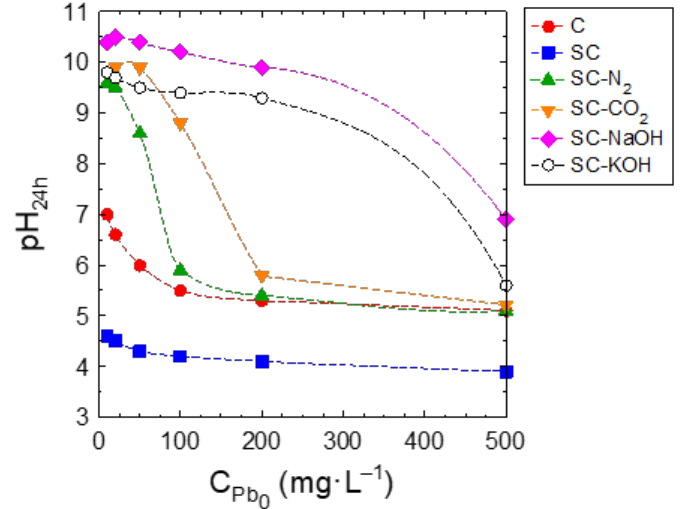
Figure 7. Adsorption isotherms of Pb onto the char from plastic pyrolysis before and after activation. The dashed lines represent the fitting to the Sips isotherm model. Experimental conditions: C Pb0 =